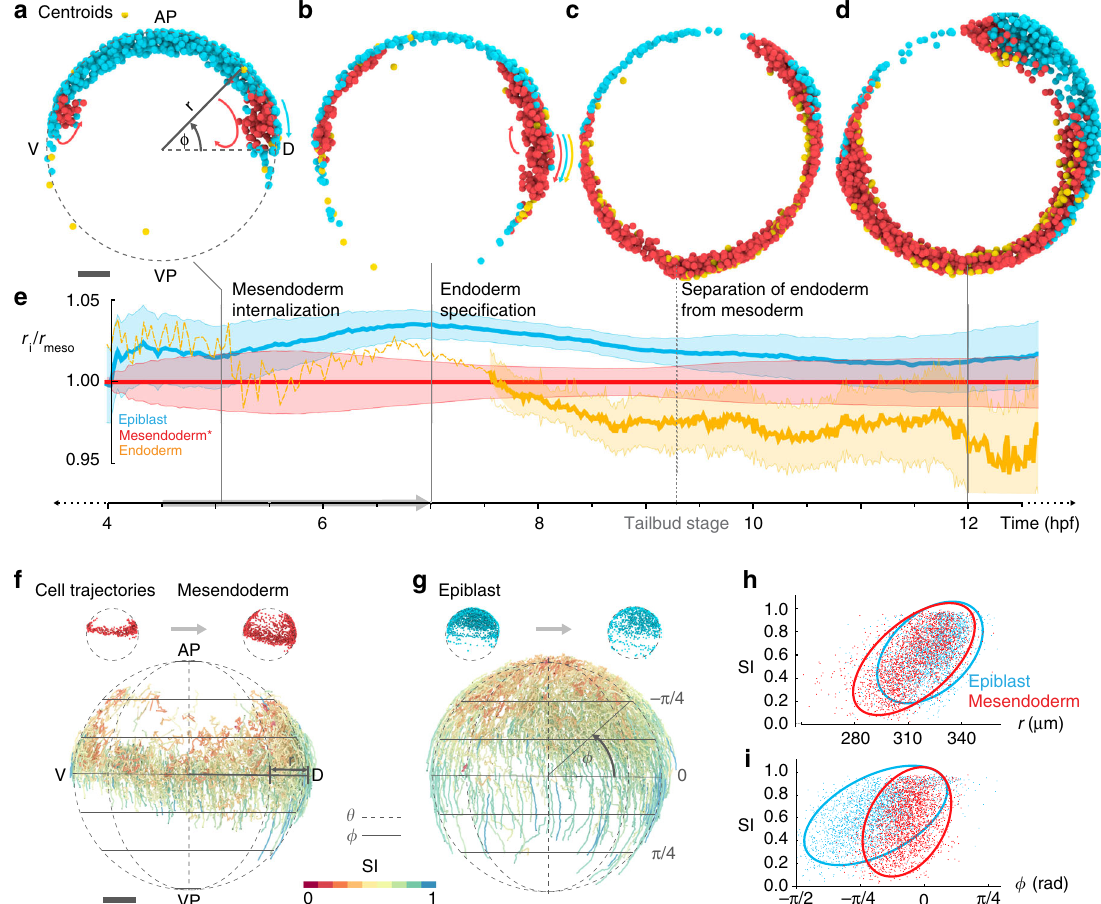
Fig. 2 Position dependent organization of cell movement during early gastrulation. a – d Lateral views of the embryo at 4, 6.5, 9, and 11.5 hpf showing rendered object centroids located within a plane through the body axis (± 78 μ m). Colors indicate the corresponding germlayer: epiblast (blue) mesendoderm (red) and endoderm (yellow). Colored arrows in ( a ) indicate epiboly of epiblast (blue) and internalization of mesendoderm (red), in b indicate epiboly movement of all three germlayers. AP: animal pole, VP: vegetal pole, D: dorsal, V: ventral. e Line plot showing mean radial position of all germlayers (normalized with respect to average radius of the mesendoderm) for a single embryo. Bands indicate mean + / − 0.3 standard deviation, the scaling was introduced to reduce overlap between germlayers and to visually highlight the thinning of layers. Dashed yellow line indicates the period before endoderm speci fi cation. f Cell trajectories for mesendodermal cells during early gastrulation (4.5 – 7 hpf; indicated by gray arrow in e ) shown in lateral view. Color code indicates the straightness indices (SI) of trajectories. g Cell trajectories for epiblast cells, same views and color code as in f . h Scatterplot of SI vs. radial position r (computed at the midpoint) for each trajectory (4.5 – 7 hpf) of mesendoderm (red), epiblast (blue) and the respective 90% prediction ellipsoids. i Scatterplot of SI vs. position Φ along the longitude (computed at the midpoint) for each trajectory (4.5 – 7 hpf) of mesendoderm (red), epiblast (blue) and the respective 90% prediction